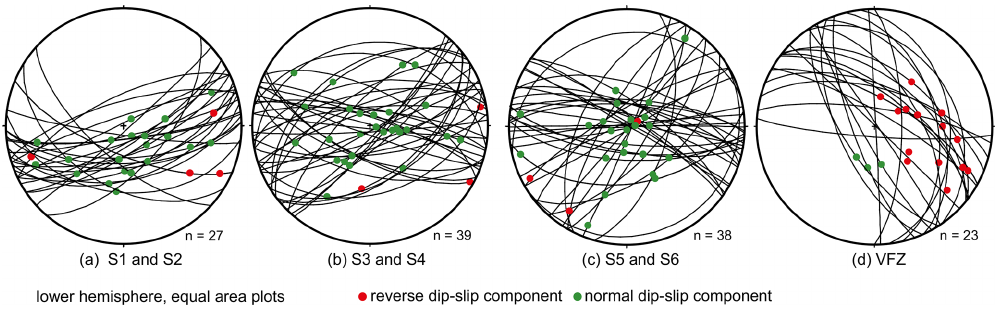
Figure 6. Stereoplots of faults related to relief rejuvenation. (a–c) Faults associated with NNW–SSE relief segmentation. (d) Fault surfaces measured in the VFS. Plots have been made with FaultKin 8 by Allmendinger (2019; http://www.geo.cornell.edu/geology/faculty/RWA/ programs/faultkin.html, last access: 21 October